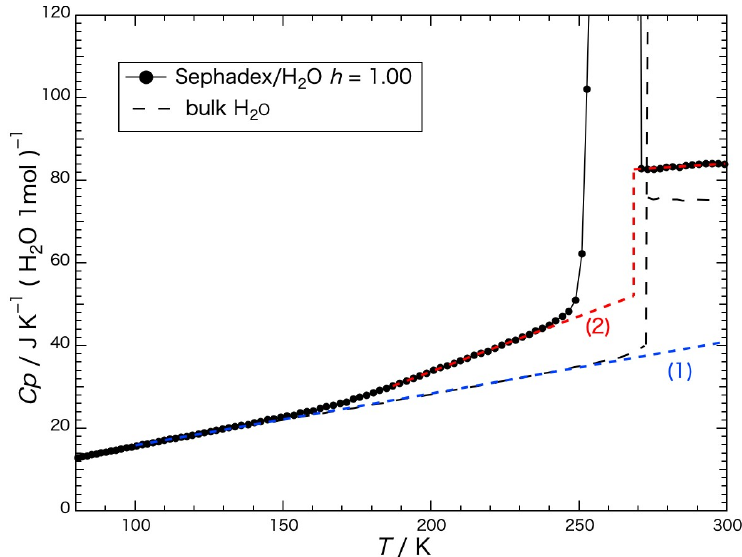
Figure 5. Heat capacities of the water per mole within the Sephadex ® G25 gel ( h = 1.00) precooled slowly. A black dashed line indicates the heat capacity of the bulk H 2 O (water or ice) [18]. The blue dashed line (1) represents the baseline for determining the configurational enthalpy, and the red dashed line (2) represents the baseline for determining the fusion enthalpy (see text for details).